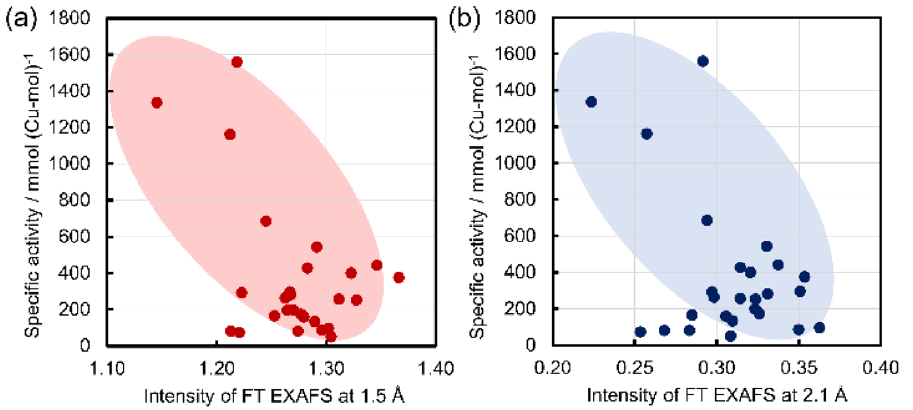
and ( b ) the intensities of Å